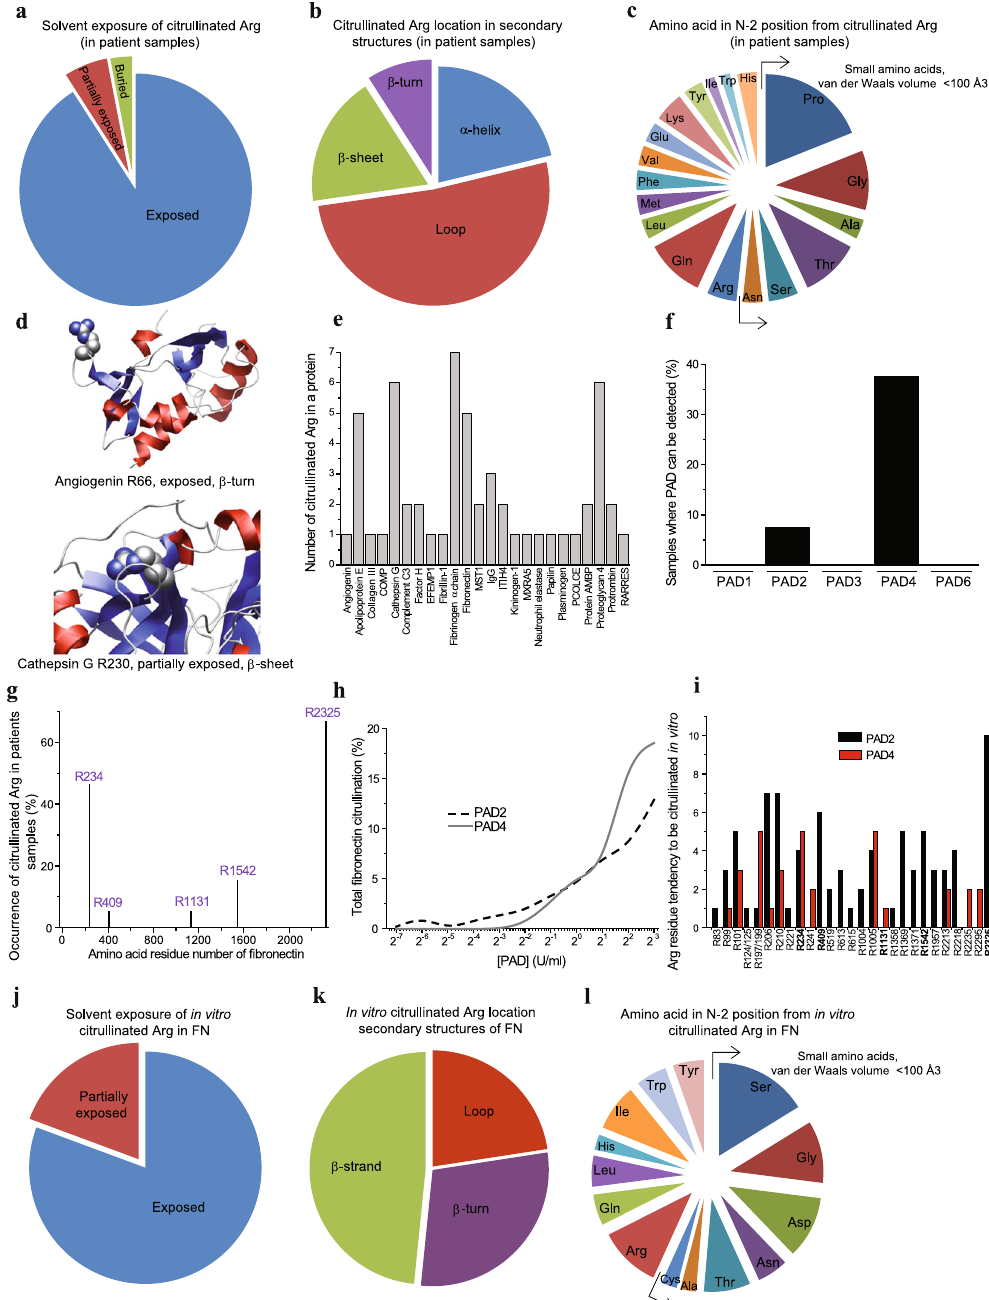
Figure 2. Extracellular citrullination is a consequence of non-selective citrullination targeted to exposed arginine side chains. The arginine residues corresponding to citrullinated arginines: ( a ) Solvent exposure in known 3D structures. ( b ) Frequency of citrullinated arginine residue location within a protein secondary structure type. ( c ) Frequency of amino acid types at position N-2 in the sequence relative to citrullinated arginine. Examples for arginine location in 3D structures: ( d ) R66 of angiogenin and R230 of cathepsin G. ( e ) The number of citrullination sites in single proteins identified in synovial fluid in inflammation. ( f ) The frequency of PAD2 and PAD4 detection in synovial fluid samples by mass spectrometry. ( g ) The citrullination sites in fibronectin and the frequency of citrullination among synovial fluid samples. ( h ) Fibronectin citrullination by PAD2 and PAD4 in vitro detected by mass spectrometry. ( i ) Fibronectin in vitro citrullination sites. The value of the arginine tendency to be citrullinated is the number of samples in which the citrullinated arginine can be detected in different PAD concentrations (7.8 mU/ml–8 U/ml). ( j – l ) For arginine residues corresponding to in vitro citrullinated arginines in fibronectin: ( j ) Solvent exposure in known 3D structures. ( k ) Frequency of in vitro citrullinated arginine residue location within a protein secondary structure type (note: fibronectin does not contain α helices). ( l ) Frequency of amino acid types at position N-2 in the sequence relative to in vitro citrullinated